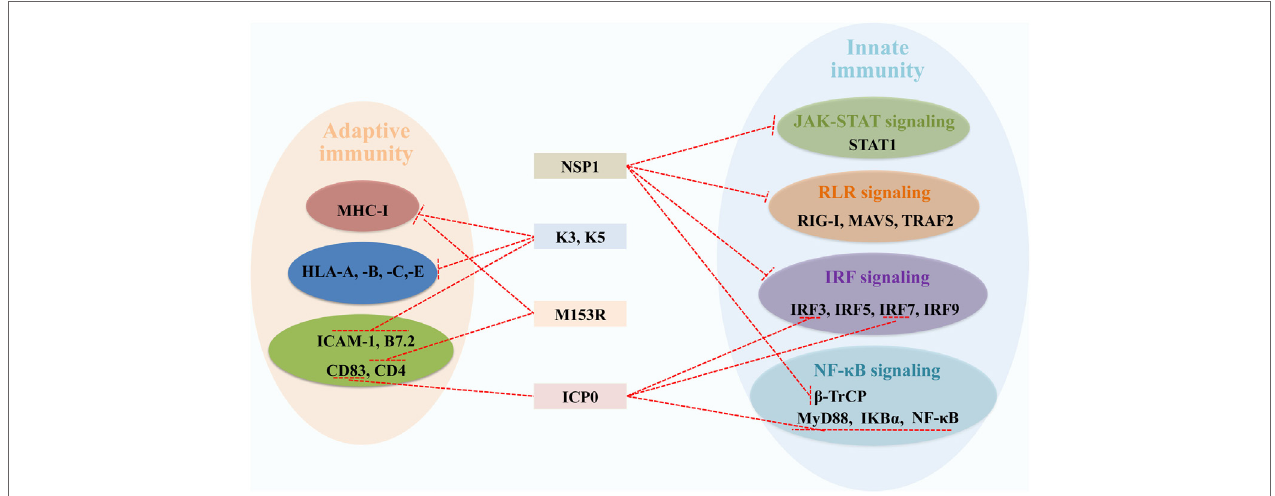
FiGURe 5 | Viral RING-domain E3 ligases counteract components of the host innate and adaptive immunity by targeting cellular proteins, which are shown with a T-shaped line in red. Abbreviations: NSP1, the non-structural protein 1 of rotavirus; K3 and K5, the K3 and K5 proteins of Kaposi’s sarcoma-associated herpesvirus; M153R, the M153R protein of myxomavirus; ICP0, the infected cell protein 0 of herpes simplex virus type 1. STAT1, signal transducer and activator of transcription 1; RIG-I, retinoic acid-inducible gene I; MAVS, mitochondrial antiviral signaling; TRAF2, tumor necrosis factor receptor-associated factor 2; IRF3, 5, 7, and 9, interferon regulatory factors 3, 5, 7, and 9; β -TrCP, β -transducin repeat-containing protein; MyD88, myeloid differentiation primary response protein; NF- κ B, nuclear factor κ B; IKB α , inhibitory κ B alpha; MHC-I, major histocompatibility complex class I; HLA-A, -B, -C, and -E, HLA class I histocompatibility antigens A, B, C, and E; ICAM-1, intercellular adhesion molecule 1; B7.2, cytotoxic T-lymphocyte-associated antigen 4 counter-receptor; CD83 and 4, CD_antigens 83 and